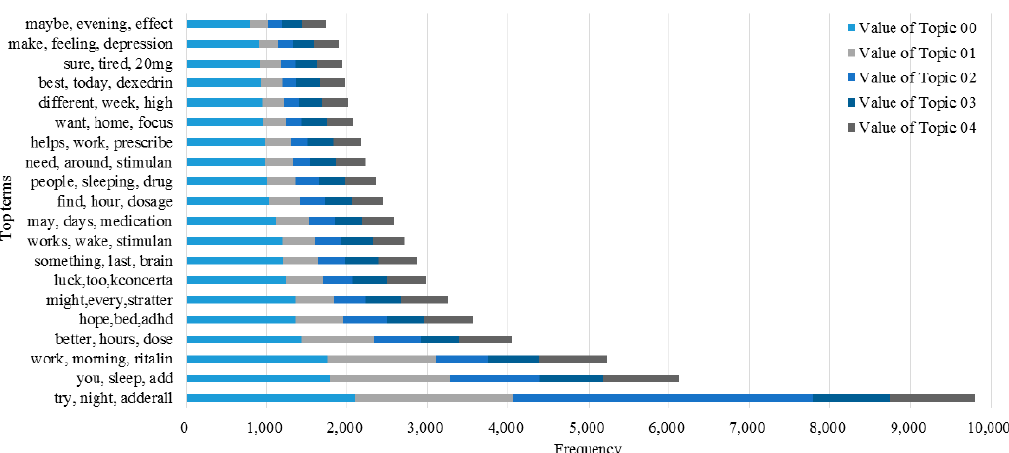
Figure 6. Comparison of frequency values of five topics with top five terms by using original posts. Int. J. Environ. Res. Public Health 2018 , 15 , x